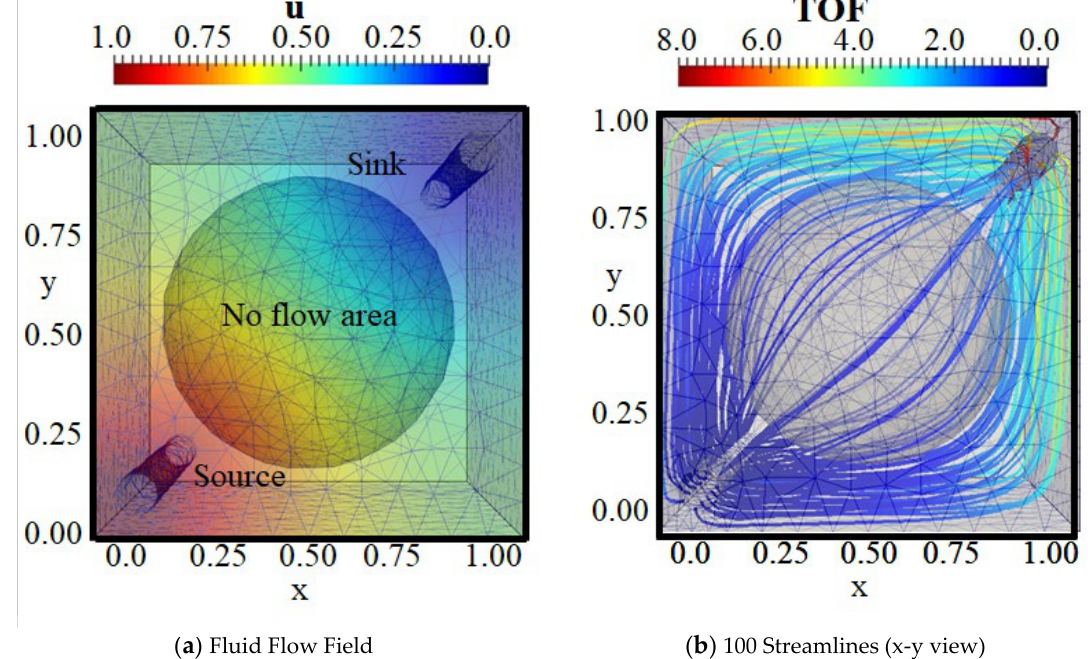
Figure 8. The result of Case 3. ( a ) The discretization of the calculation domain and the potential field ( u ), and ( b ) streamline pattern from the x - y plane view.